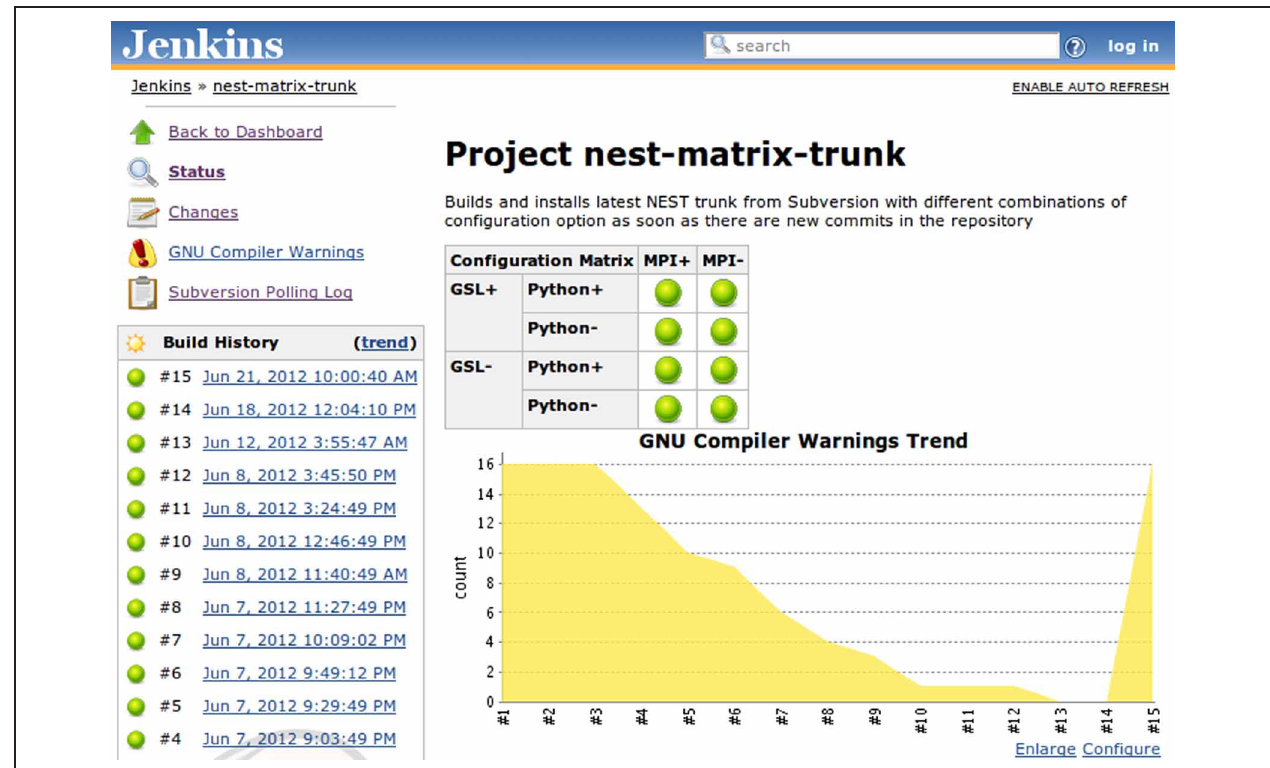
FIGURE 5 | Matrix build set up for the main branch of NEST. Every time a change is committed to the repository, all major configurations are built, installed and tested to catch regressions in the functionality in a timely manner.